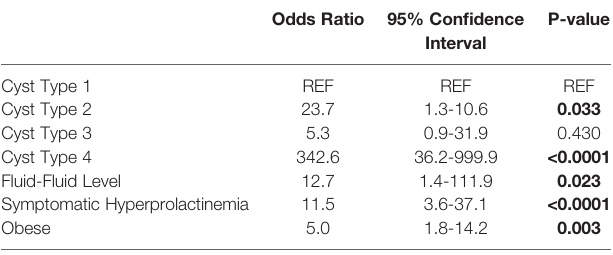
TABLE 3 | Adjusted predictors of cystic pituitary adenomas versus Rathke cleft cysts.